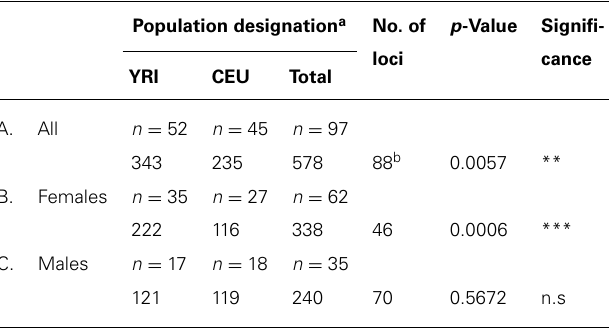
Table 5 | Gender comparisons of the CNV numbers among OR pseudogenes for one-copy loss between two